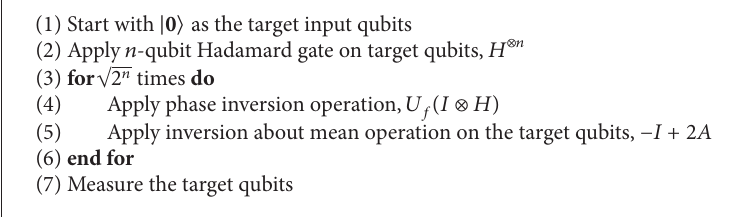
Algorithm 1: Grover’s search algorithm.